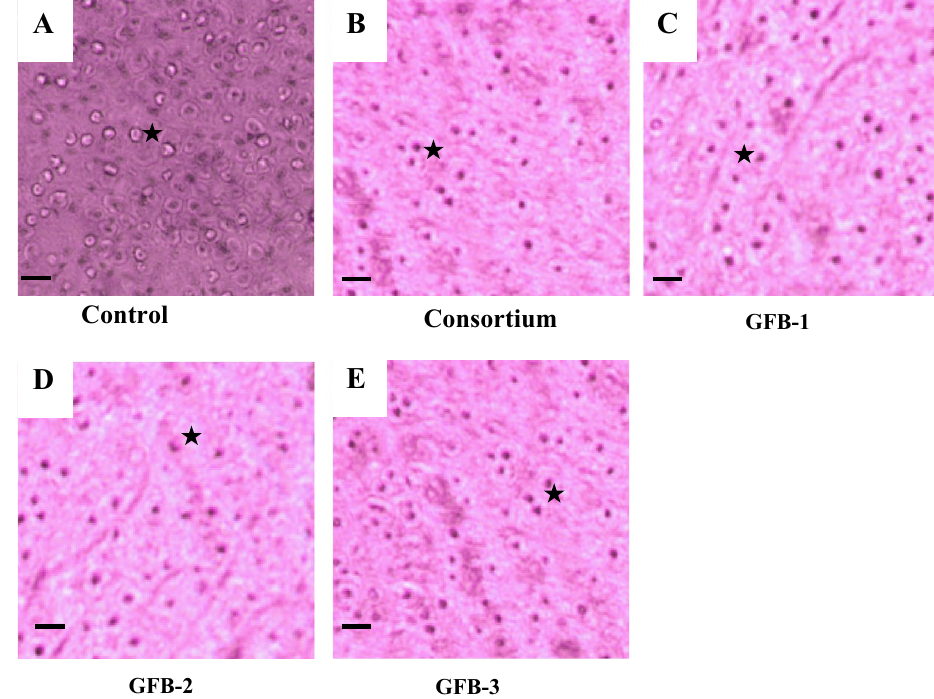
Figure 6. Histological analysis of the effects of probiotic supplementation on liver (A-E) of B. gonionotus . Fishes were fed on (A) control diet (0 CFU kg −1 feed), (B) consortium (T2) (1.35 × 10 9 CFU kg −1 feed), (C) GFB-1 (1.62 × 10 9 CFU kg −1 feed), (D) GFB-2 (1.43 × 10 9 CFU kg −1 feed) and (E) GFB-3 (1.06 × 10 9 CFU kg −1 feed). (A) It shows unclear hepatocyte cells (arrow) with irregular shaped nucleus (asterisk). (B), (C), (D) and (E) show the hepatocytes with regular shaped nucleus. Six fishes were considered for each treatment (n = 6). Image 40x; scale bar = 50 µm; H & E